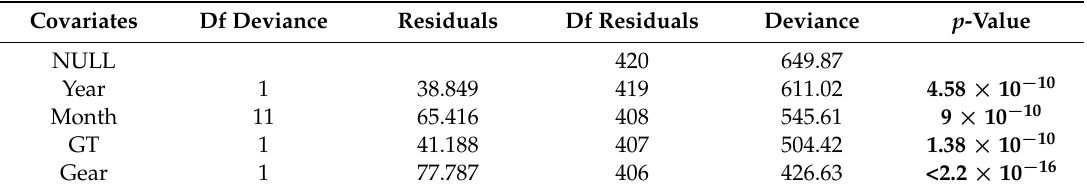
Figure 4. Comparison between sharks caught by different month ( top left ), by different year ( top right ), by different vessel sizes ( bottom left ) and by different total effort (set x number of hook) ( bottom right ). Data was represented using boxplots for the categorical variables (month and year). Table 1. Analysis of variance for the covariates of the best fit models (Equation (1)), which affect the catches of silky shark landed in Tanjung Luar and Cilacap (significant values are highlighted in bold). Df, Degree of freedom; GT, Gross Tonnage.